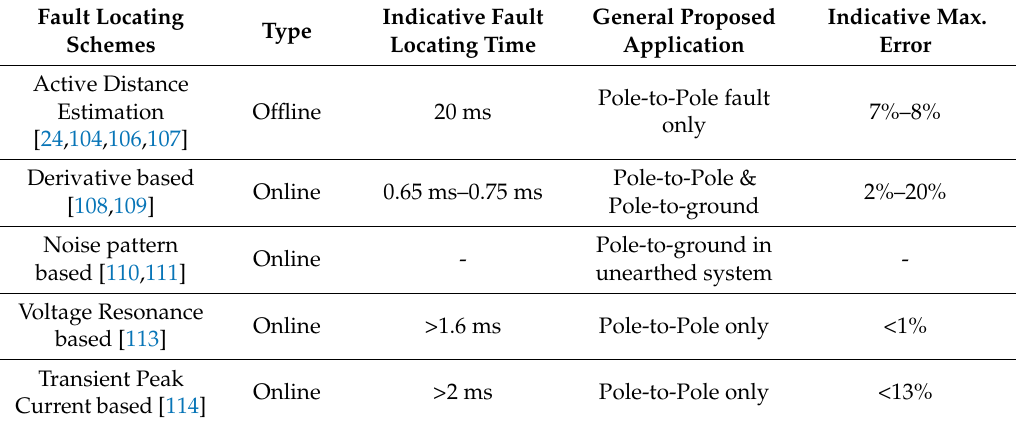
Table 3. Comparison of Different Fault Location Schemes for LVDC